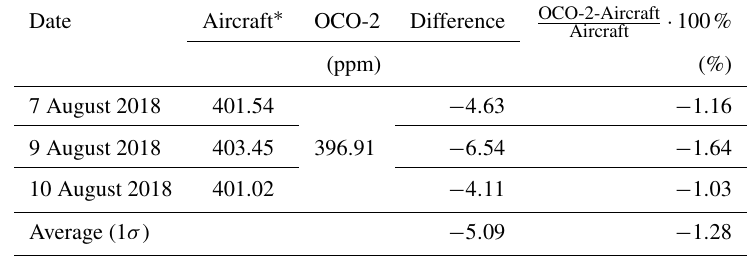
Table 3. The same as Table 2, but for method